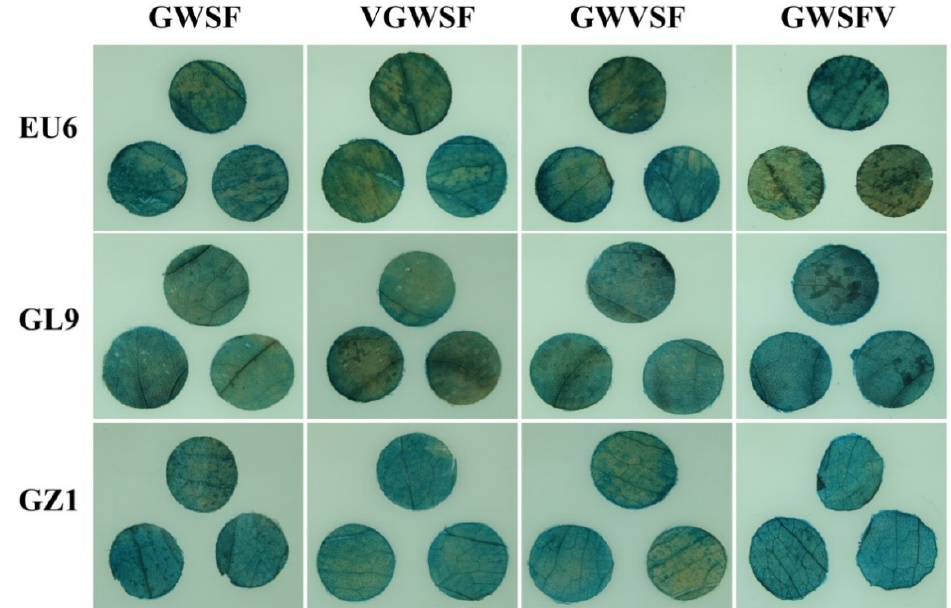
Figure 3. GUS histochemical staining evaluation of the basal transcription activities of the improved promoters in eucalyptus leaf discs. Leaf discs of eucalyptus were prepared as described in the materials and methods. EU6: E.urophylla U6; GL9: E.urophylla × E.grandis Guanglin 9; and GZ1: E.urophylla × E.tereticornis Guangzhou 1.